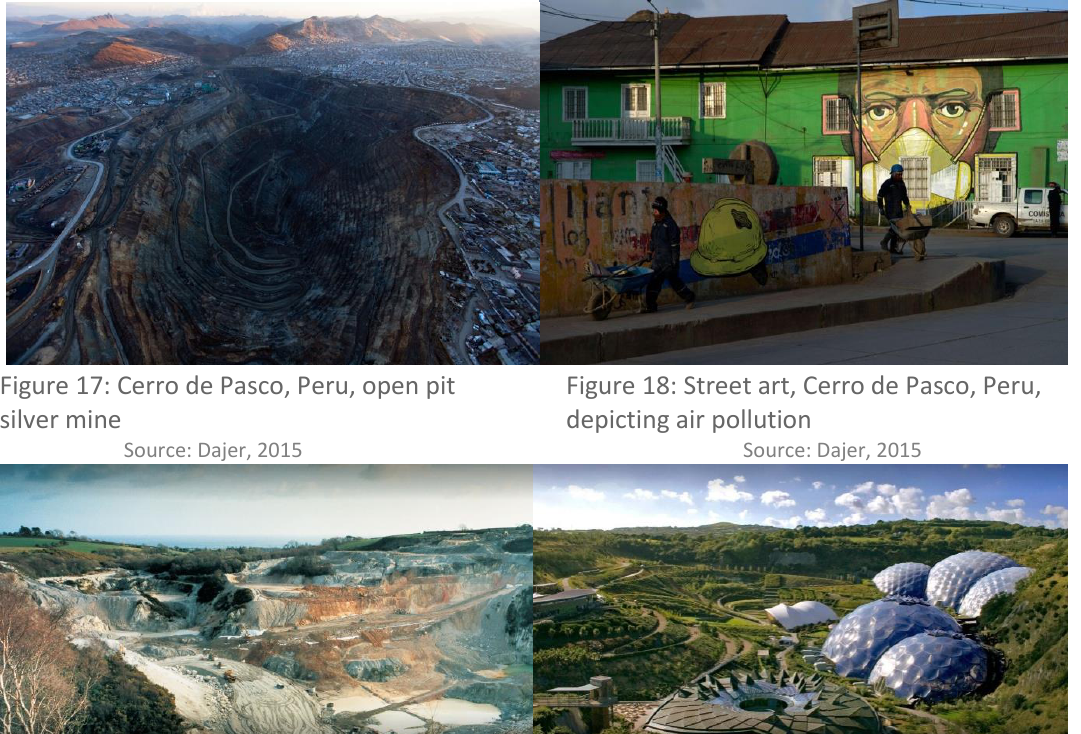
Figure 15: Kremnica, Slovakia, supports Roşia Figure 16: Open pit gold mining 1 km Montană during the protests in 2013 from Kremnica - simulation